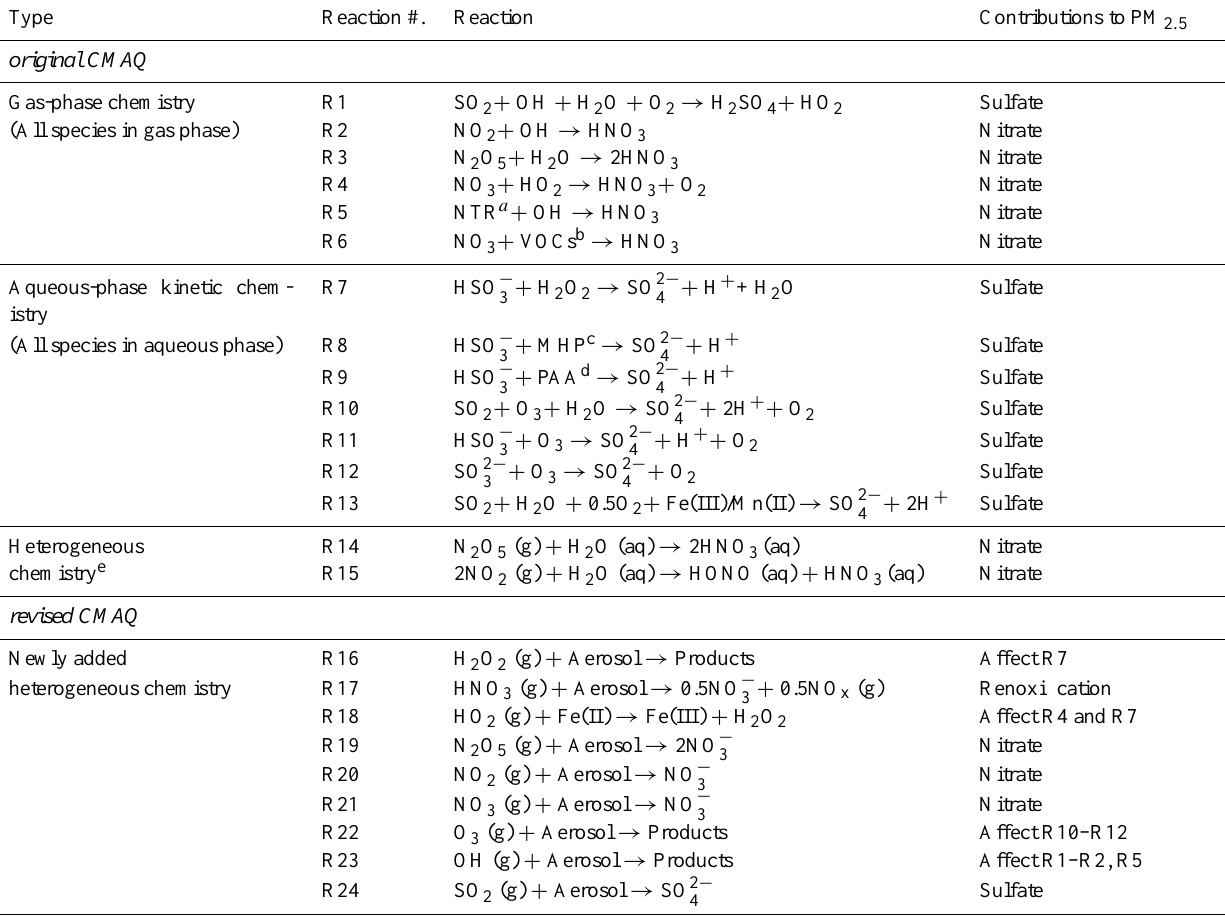
Table 1. Main reactions contributing to sulfate and nitrate production in original CMAQ and heterogeneous reactions newly added in revised